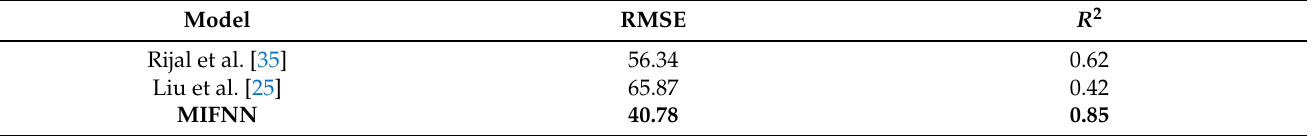
Table 5. Performance comparison of two selected models with that of the MIFNN model.